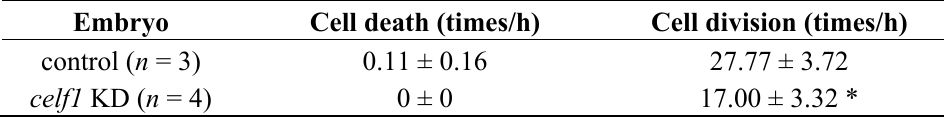
Table 1. Frequency of cell death and